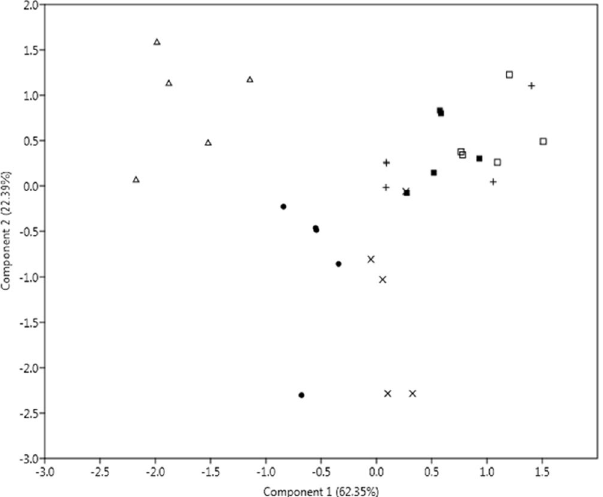
Figure 5. PCA model based on transmission data analysed by IR spectra of the six accessions of C. tora . The percentage of variation of the data explained by each component is provided in the plot. Dot, plus, square, triangle, X and fill square symbols indicated CT-1, CT-2, CT-3, CT-4, CT-5 and CT-6 populations, respectively.